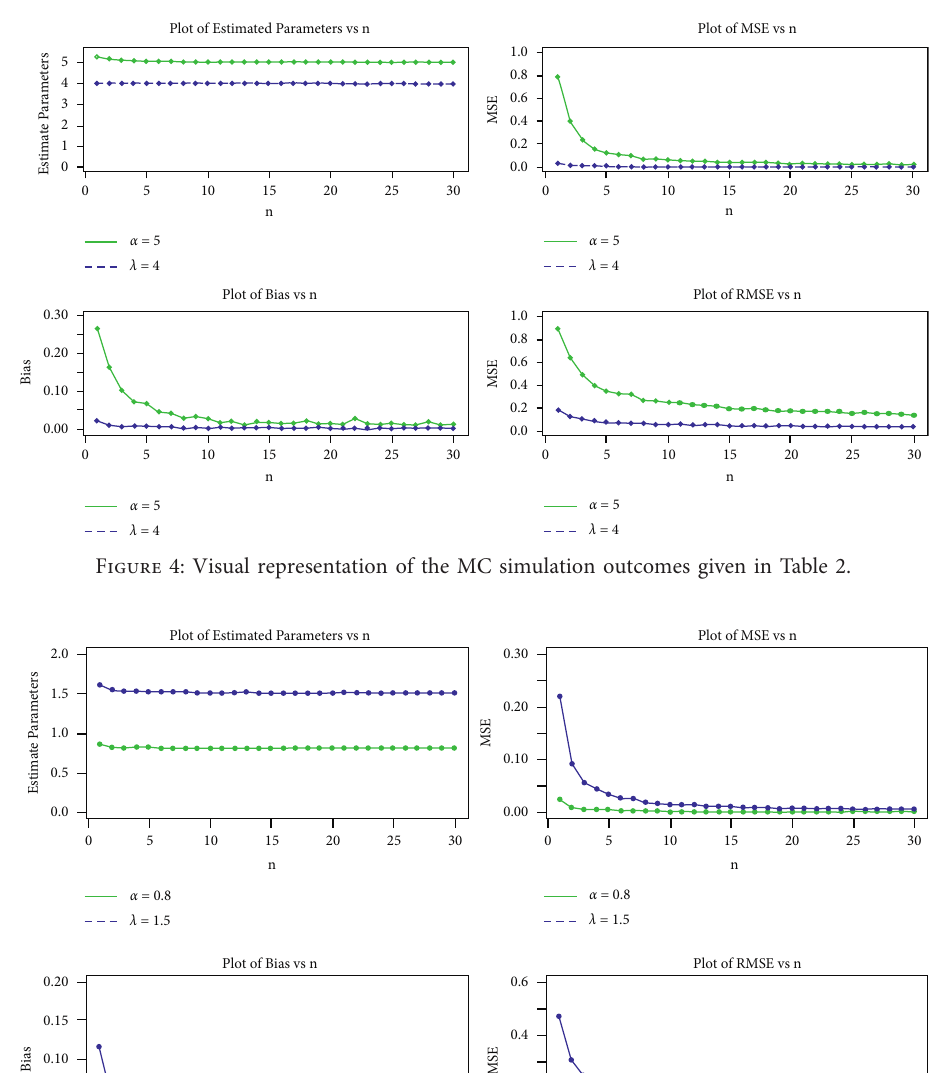
Plot of Bias vs n Plot of RMSE vs